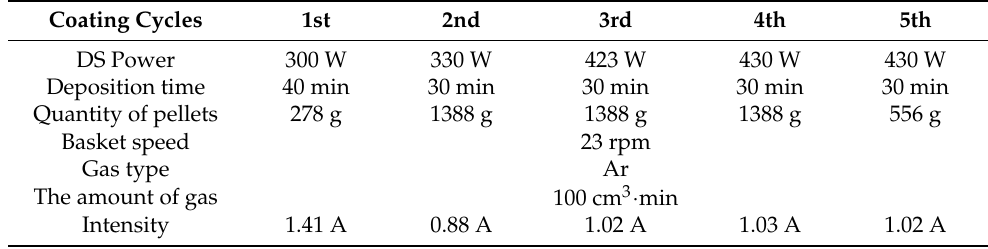
Table 1. Parameters used for nano-silver sputter coating of the Arboblend V2 Nature. Coating Cycles